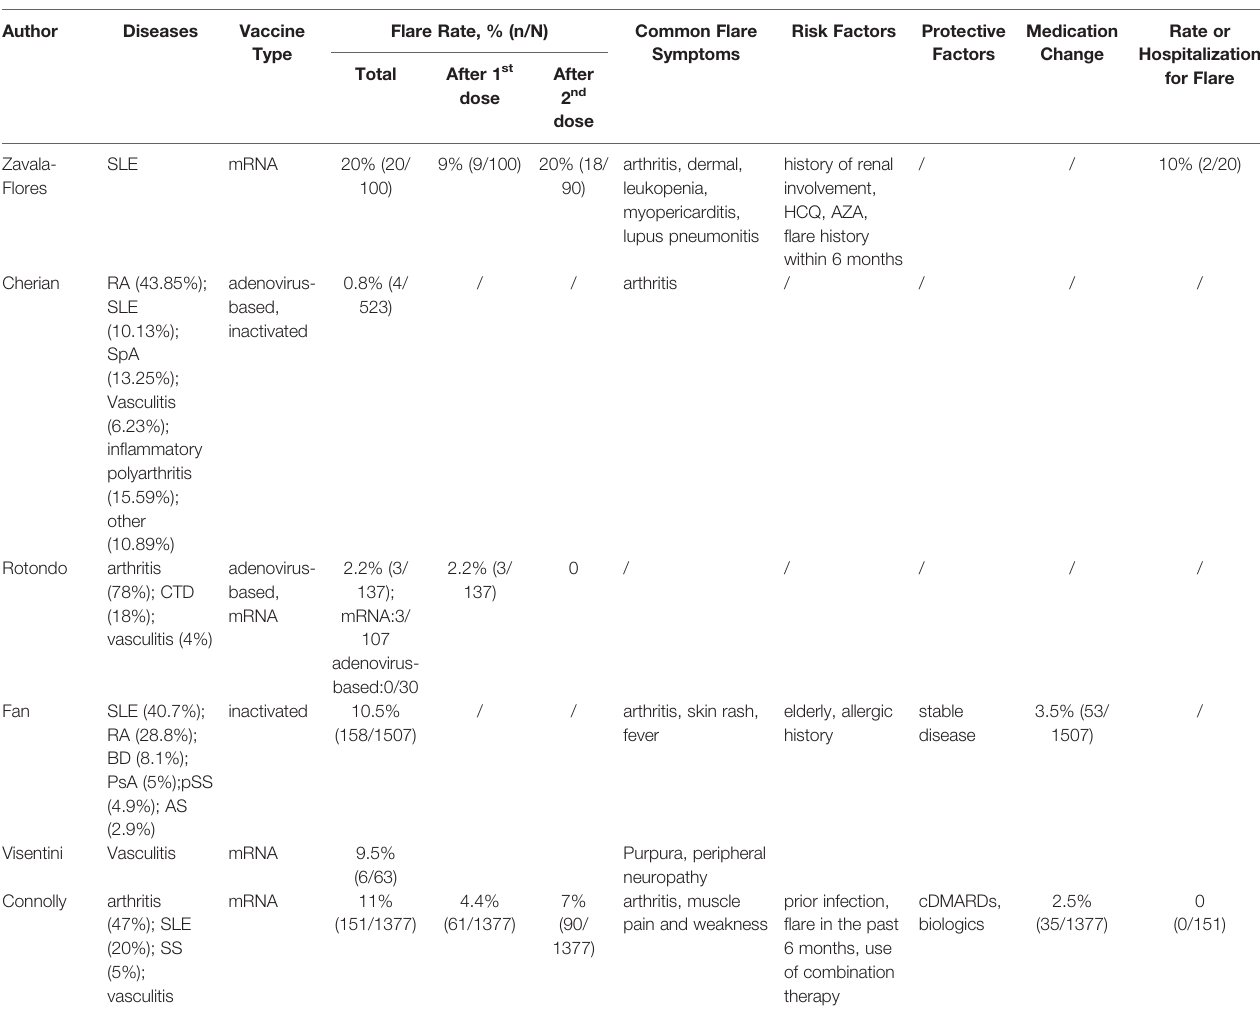
TABLE 1 | Summary of studies on a fl are-up of RDs after COVID-19